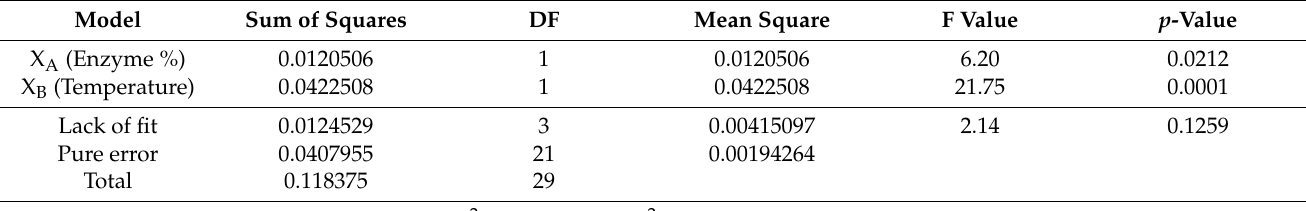
Table 3. Analysis of variance (ANOVA) for ORAC results obtained for the subtilisin Box-Behken design. Model